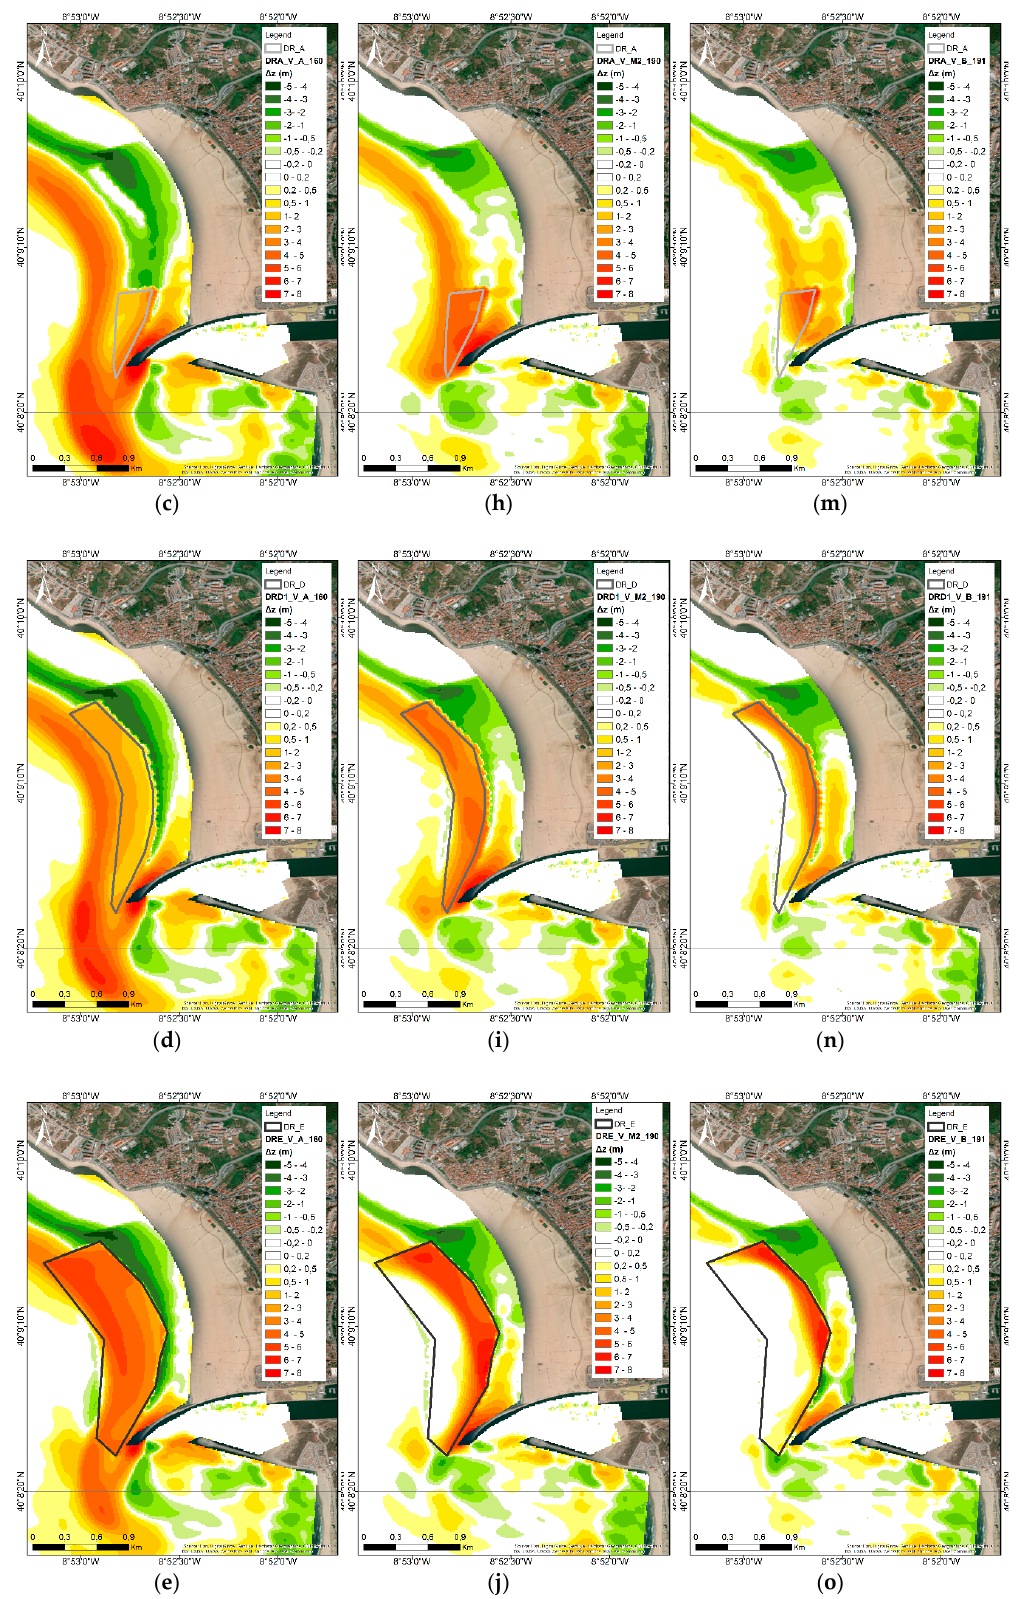
Figure 6. Bathymetry di ff erences after the three-month period of simulation for the reference (NDR) and all dredging scenarios (DRO, DRA, DRD_1, DRD_2 and DRE) under all wave climate scenarios: ( a – e ) high-energy wave 2014, ( f – j ) medium-energy wave 2007, and ( k – o ) low-energy wave